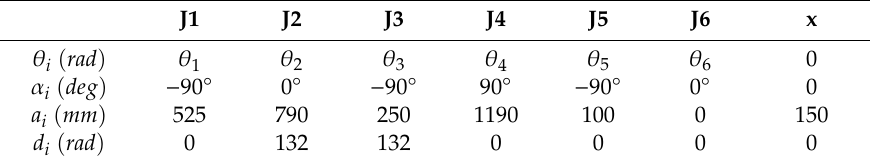
Table 1. Denavit–Hartenberg (DHm) parameters of the robot in the research